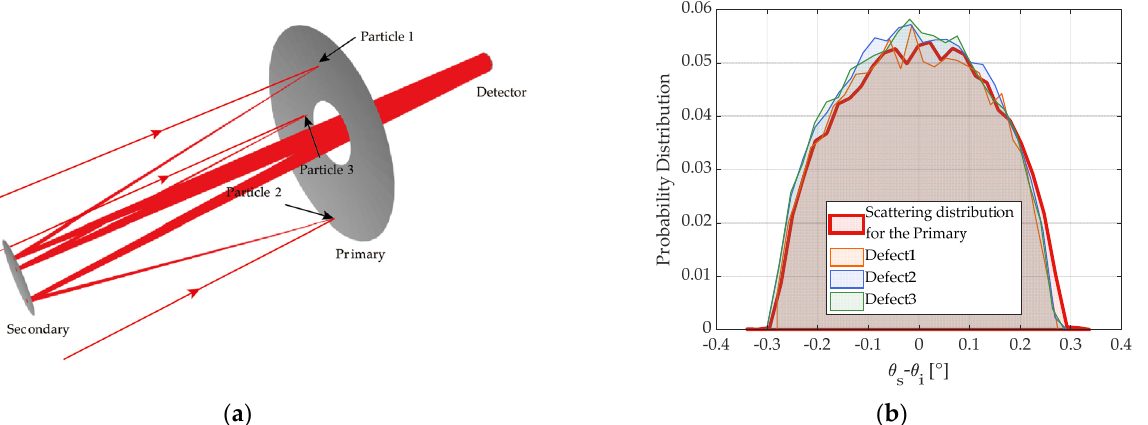
Figure 12. The scattering caused by local particles. ( a ) The optical path of the scattering which filled the entire detector. ( b ) The probability distribution of angular deviation from the specular direction due to small particle scattering.